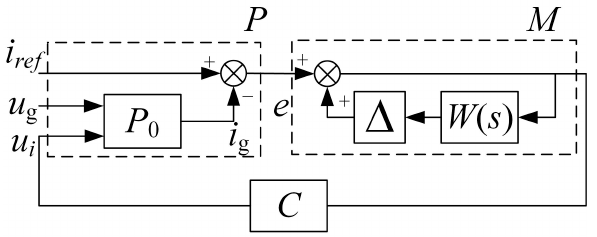
Figure 4. Block diagram of the current control scheme with the proposed controller.